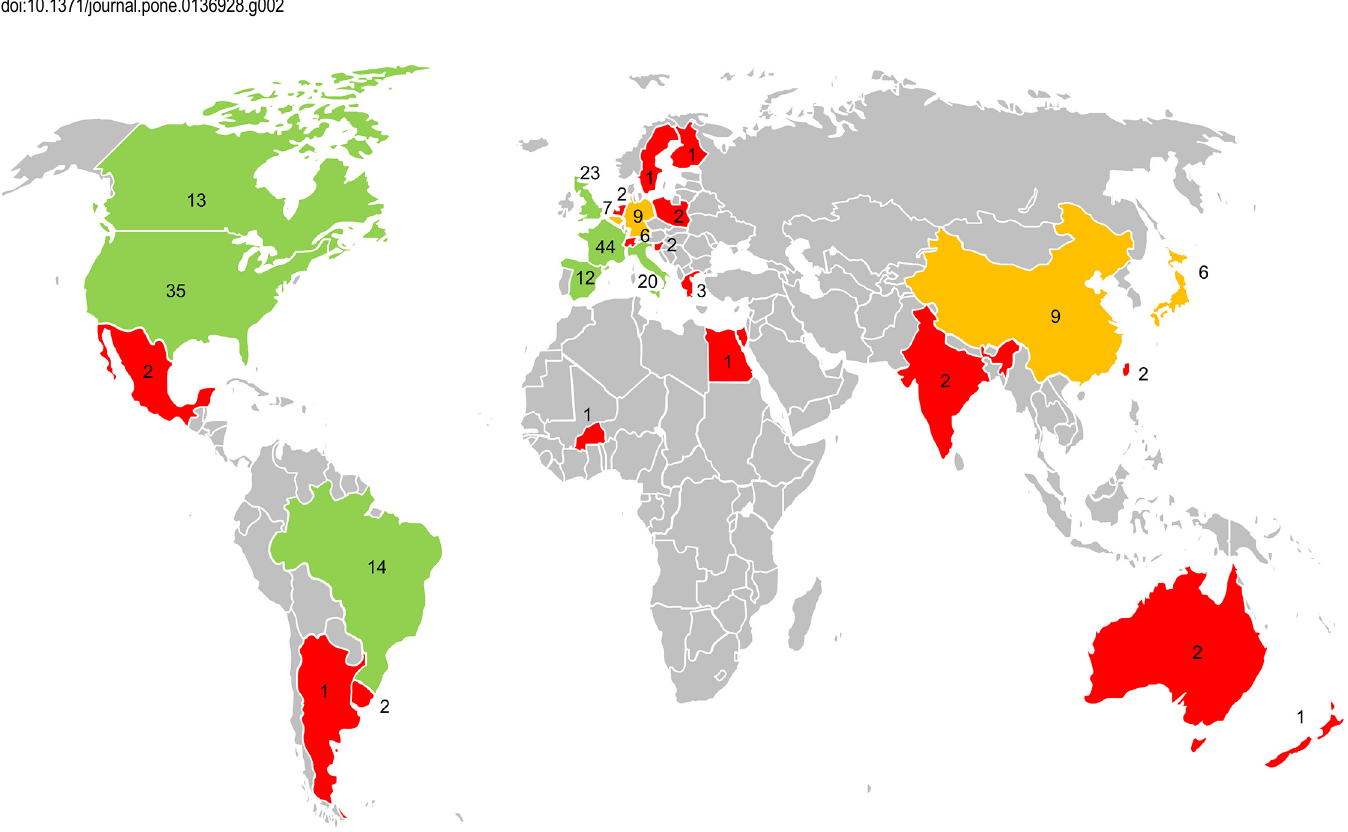
Fig 3. Geographical distribution of research on neonicotinoid impacts on bees. The number of primary research studies from each country is indicated. Colours indicate countries with 1 – 5 studies (red), 6 – 10 studies (orange) or more than 10 studies (green).